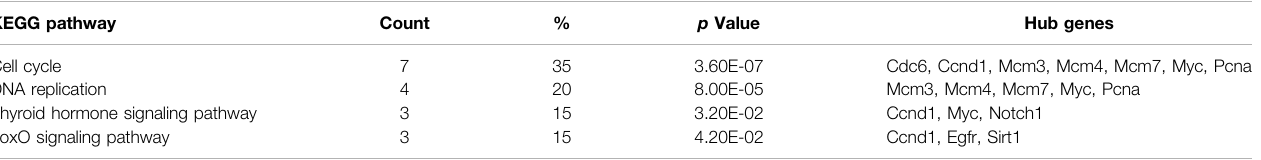
TABLE 3 | KEGG enrichment analysis of the hub genes. KEGG pathway